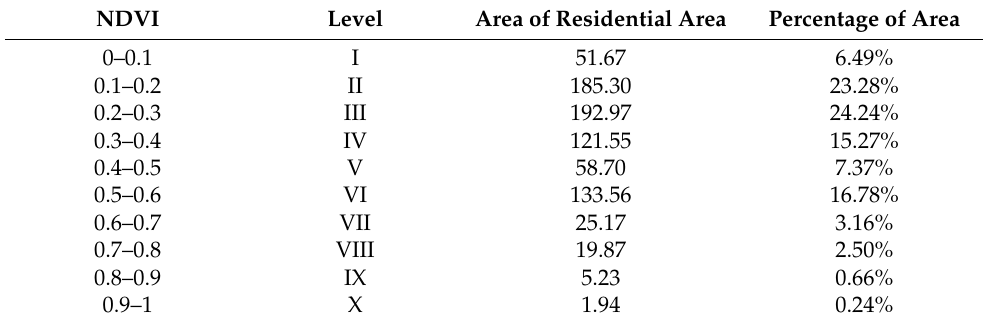
Table 5. Area and proportion of residential areas under different NDVI